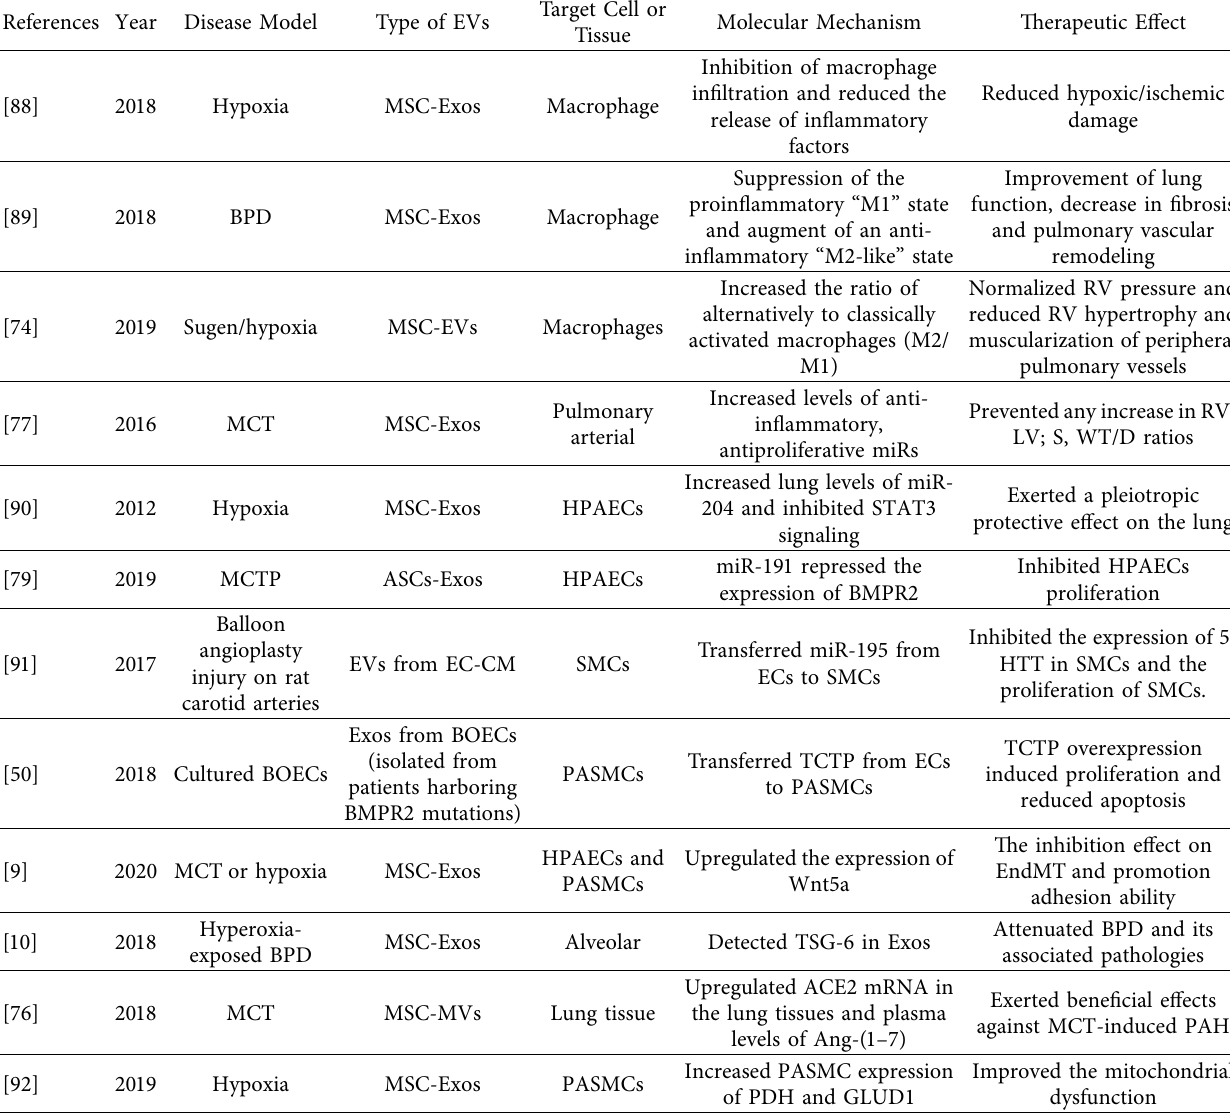
Table 2: Te mechanism analysis of EVs against